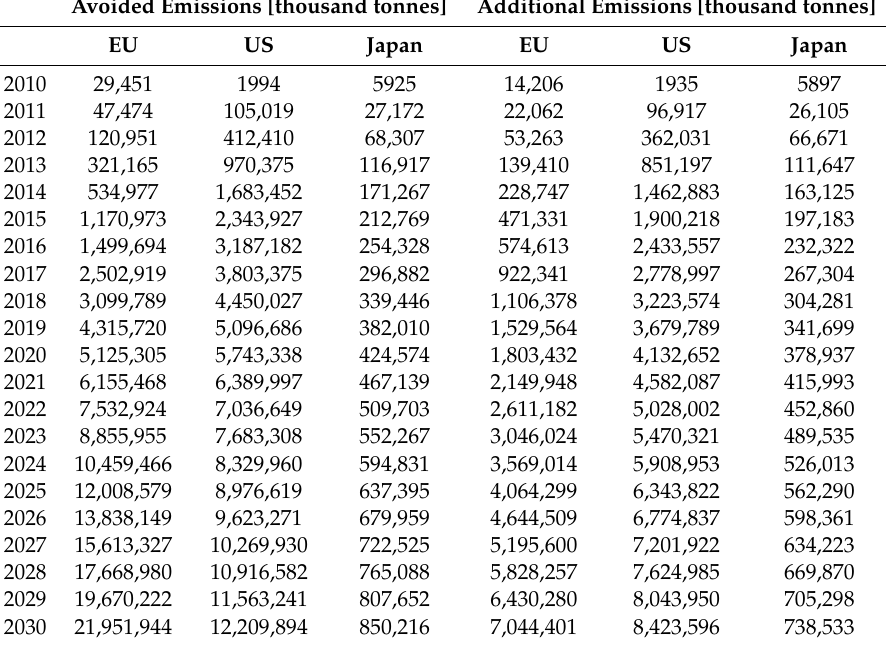
Table 6. Adjusted CO 2 emission reduction